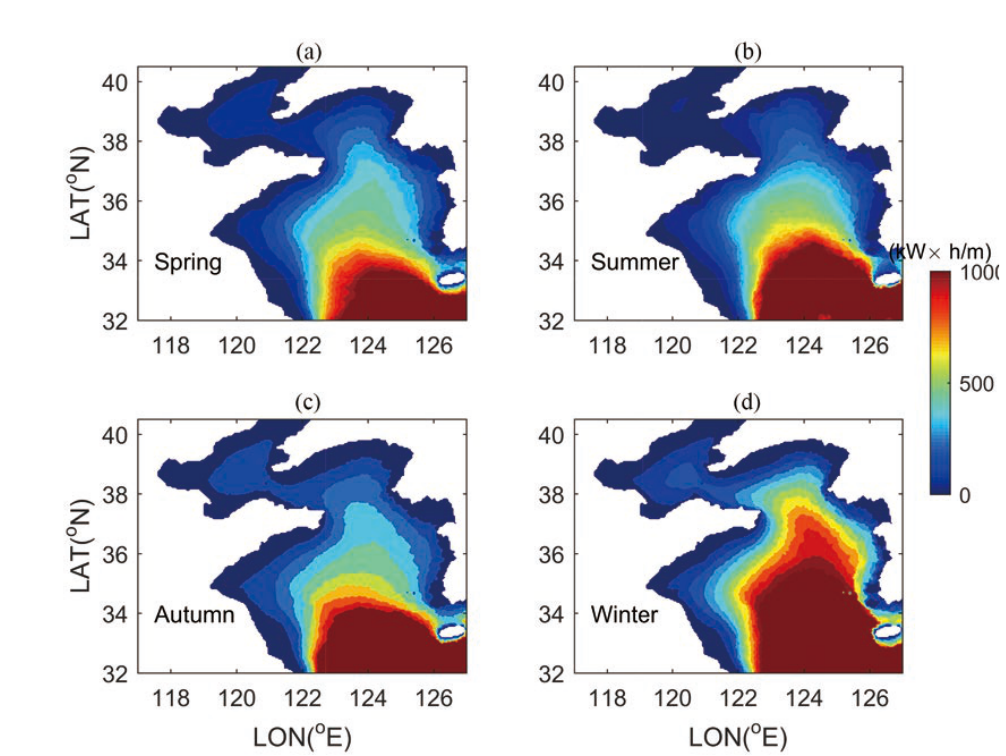
Figure 12. Seasonal average wave energy storage of the wave energy event (( a ) Spring; ( b ) Summer; ( c ) Autumn; ( d )